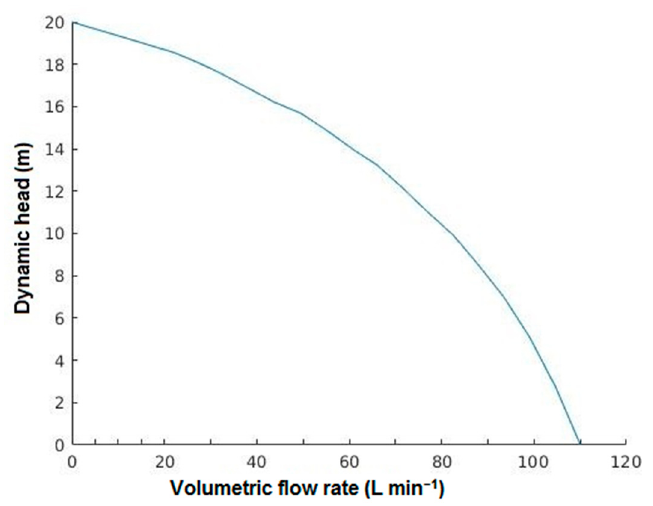
Figure A4. Experimental low-pressure pump characteristic curve.